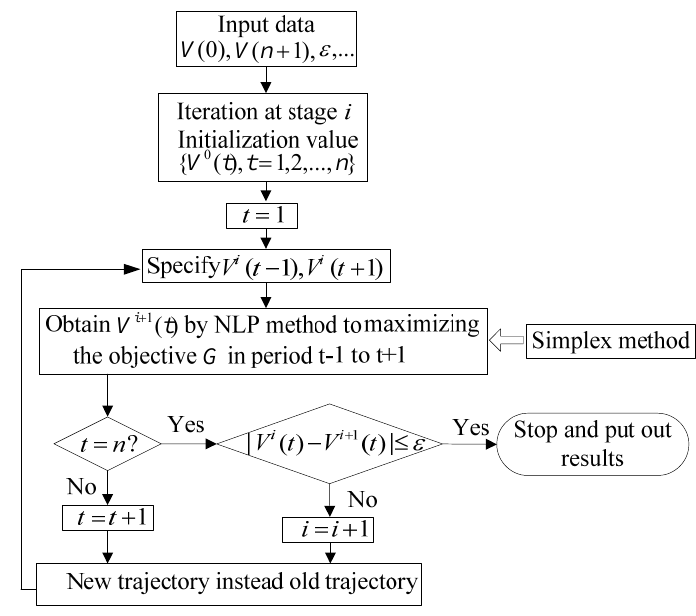
Figure 2. Sketch of progressive optimality algorithm (POA) to solve the reservoirs’ optimal